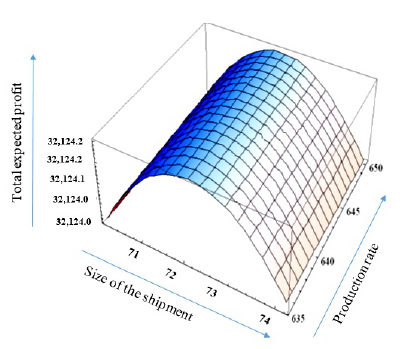
Figure 2. Total Expected Profit (TEP) versus size of shipments and backordering quantity.